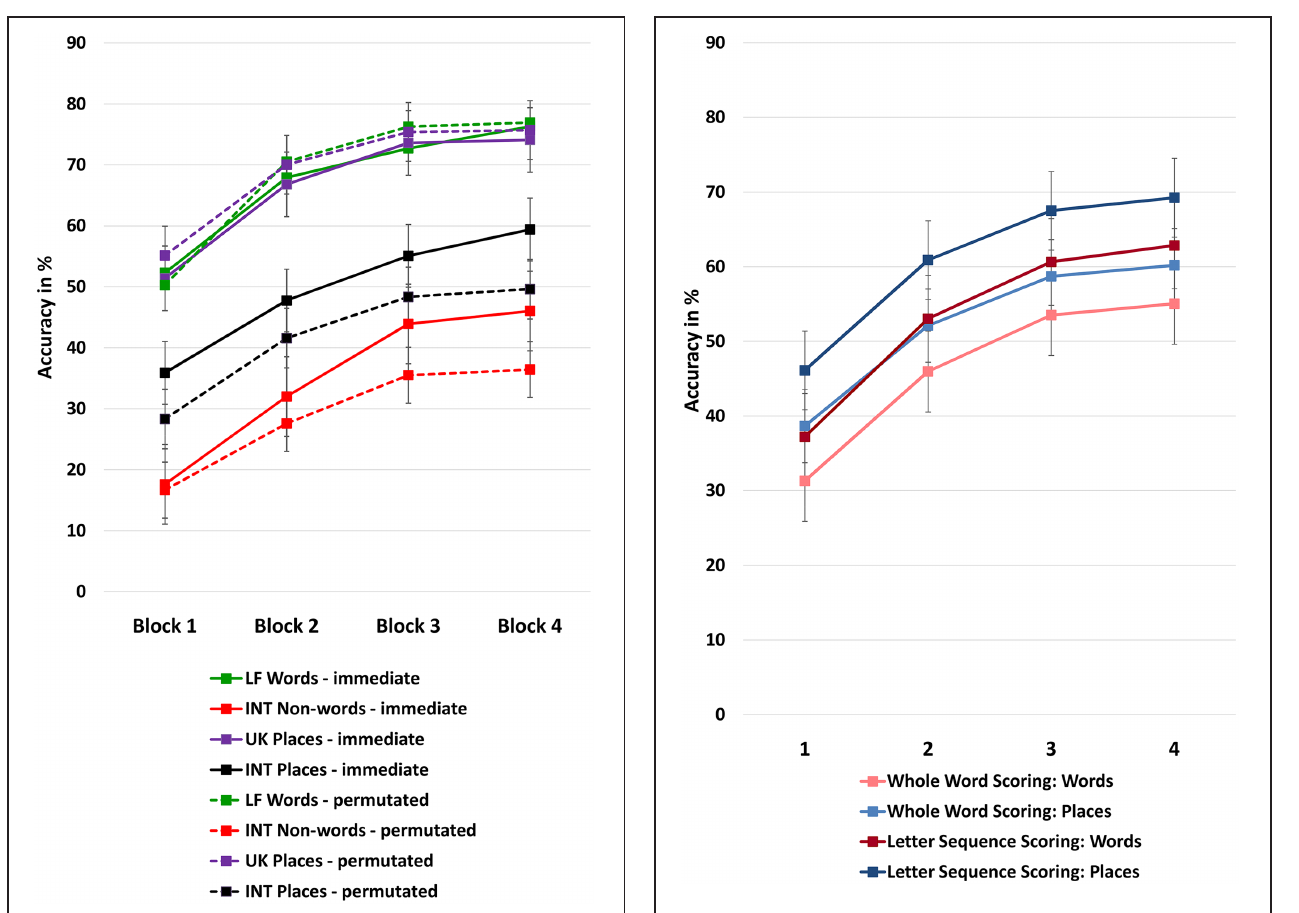
FIGURE 1 | Effect of training. Immediate repetition is denoted by the solid lines, the permutated memory block condition is denoted by the broken line. Immediate repetition is significantly more efficient for word memory recall than incidental encounters (permutated sequence of word type lists) when words are less familiar. LF = low frequency, INT = international, UK = United Kingdom. Means are controlled for age. The bars represent the standard error.